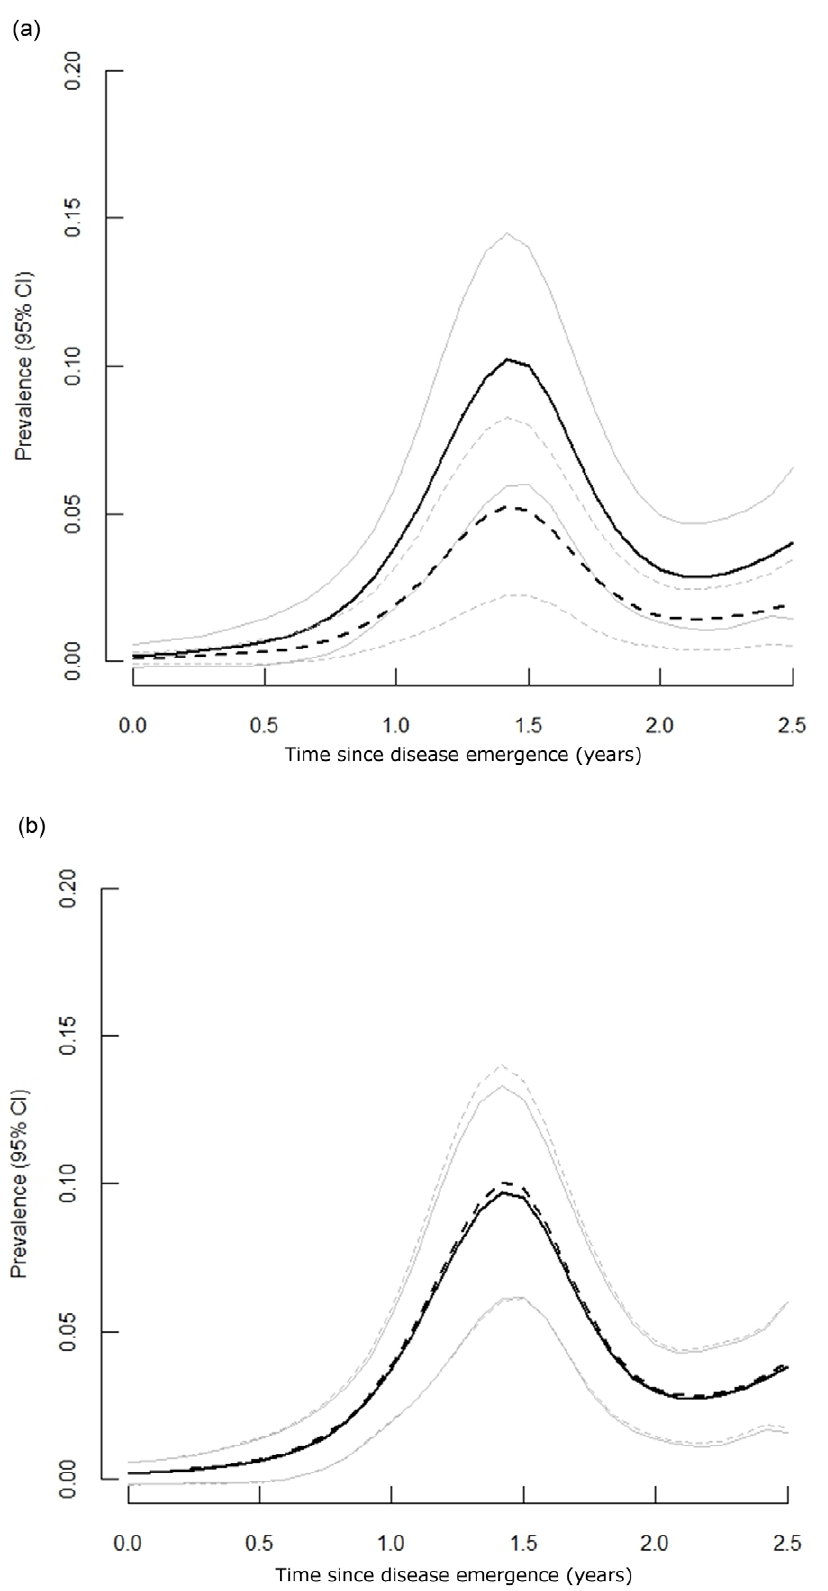
Figure 2. Predicted pox prevalence in residents (solid lines) and immigrants (dashed lines) according to host age. (a) adults (1 + years of age) and (b) juveniles ( , 1 year). Light grey solid and dashed lines are the 95% CI of the estimates of the predicted prevalence for residents and immigrants respectively. doi:10.1371/journal.pone.0038316.g002 PLOS ONE | www.plosone.org